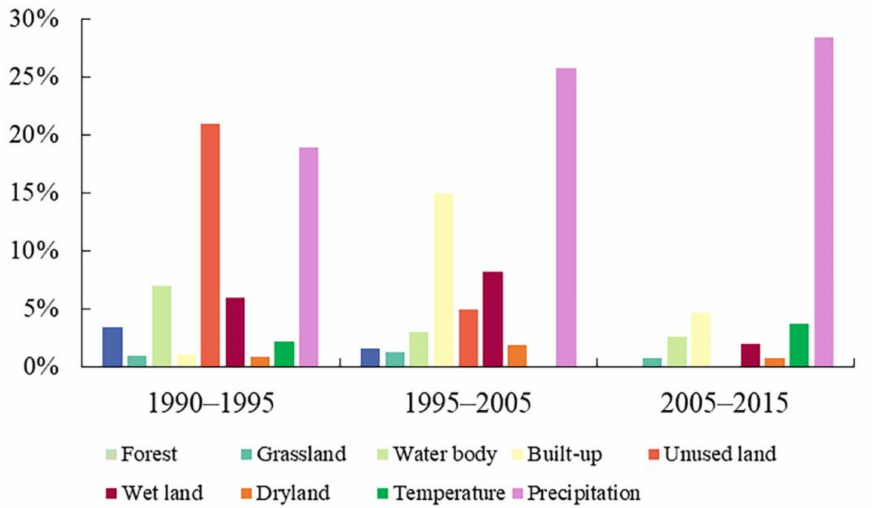
Figure 8. The change rates of LUCC, temperature, and precipitation during 1990–1995, 1995–2005, and 2005–2015.